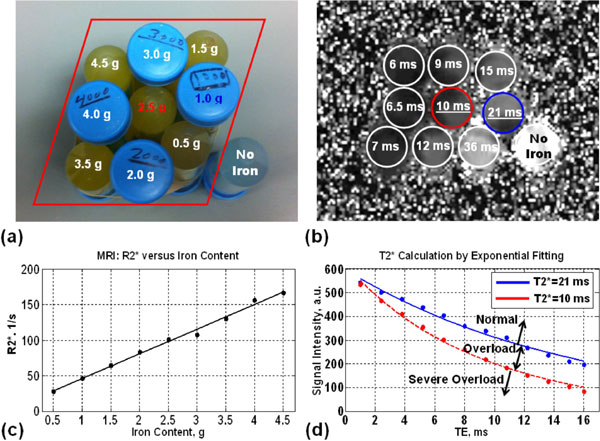
MRI Results. (a) Picture of the phantom with different iron contents (in grams) identified. (b) T2* map showing estimated T2* values for different tubes. (c) Linear relationship between iron content and R2* (= 1000/T2*). (d) Exponential fittings of the T2* relaxation curves versus echo time (TE) for the tubes that resulted in T2* of 21 ms (blue) and 10 ms (red), which represent the boundaries for iron overload and severe iron overload, respectively. Three regions can be identified on this figure for relaxation curves from tissues with normal iron content (T2* > 21 ms), iron overload (10 ms < T2* < 21 ms), and severe iron overload (T2* < 10 ms).